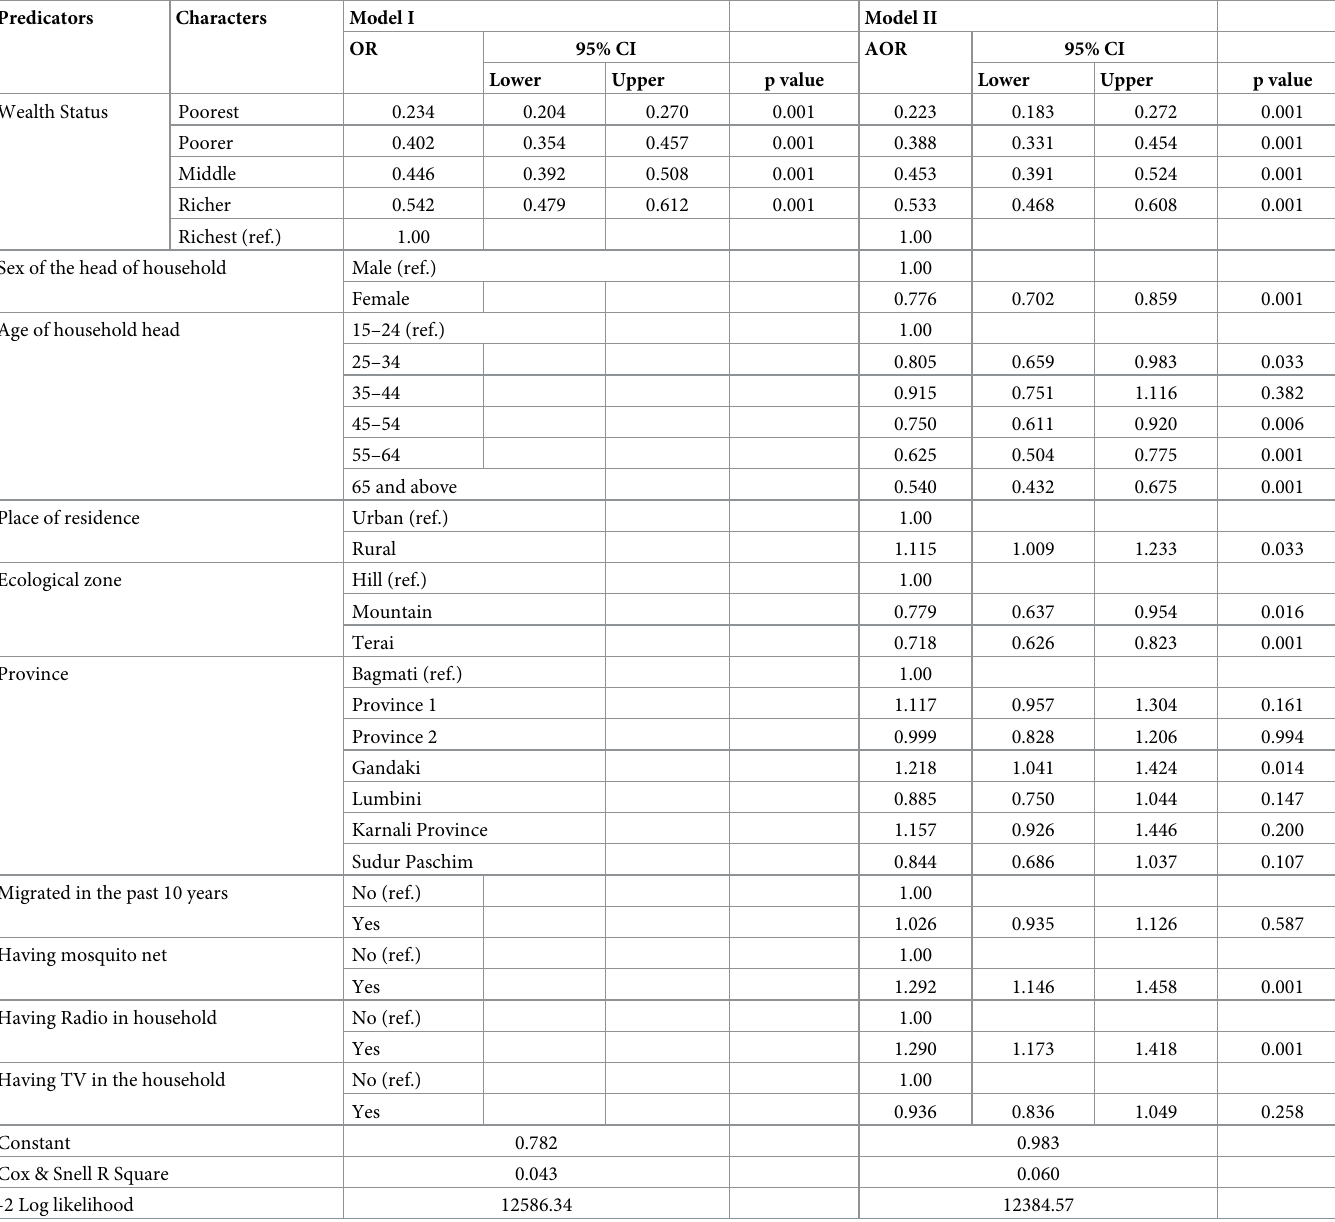
Table 4. Adjusted odds ratio of having knowledge of transmission of Lymphatic